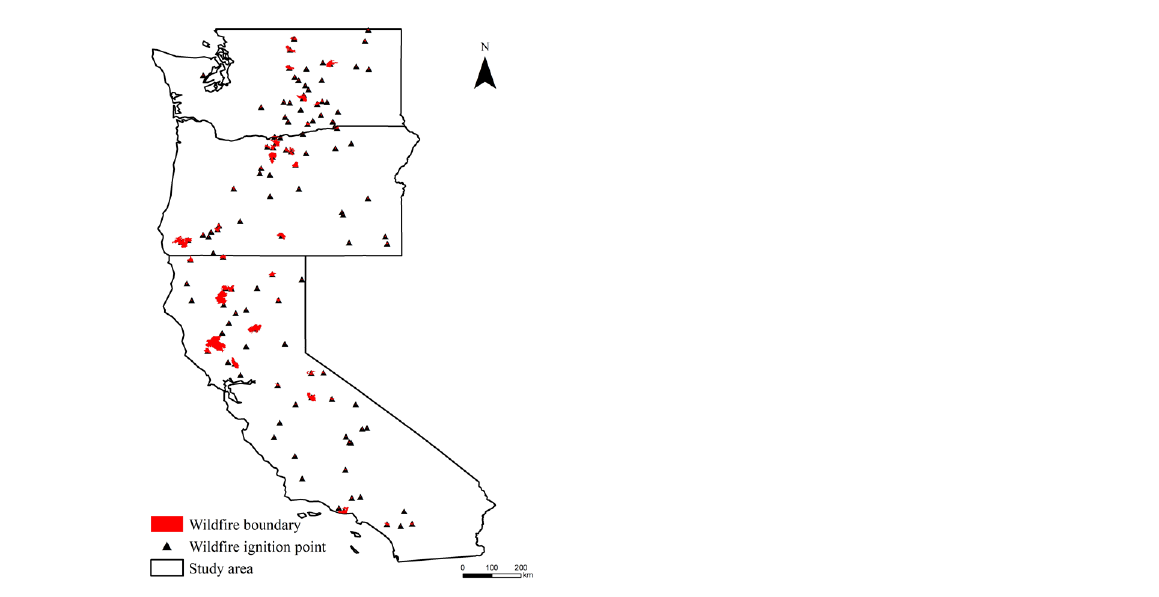
Figure 2. The ignition points and burn boundaries for large wildfires in the western United States. The percentage of the monthly number of fires and hectares burned in 2018 is pre- sented in Figure 3. Most wildfires in Washington occurred in July and August. Similarly, wildfires in Oregon were also concentrated in July and August. In California, wildfires occur mostly in July. Among these three states, in 2018, California ranked first in terms of area burned (828,703 hectares), followed by Oregon (445,635 hectares) and Washington (241,797 hectares).